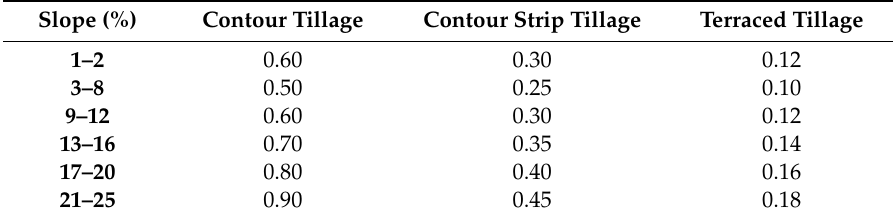
Table 4. Erosion control factor P